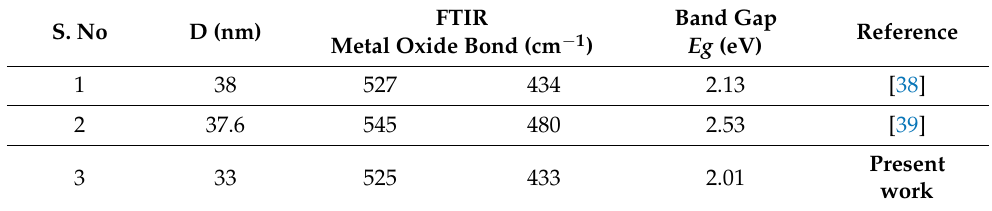
Table 2. UV-DRS bandgap comparisons with XRD and FTIR of α -Fe 2 O 3 nanoparticles. FTIR Band Gap S. No D (nm) Reference Eg (eV) Metal Oxide Bond (cm − 1 ) 1 38 527 434 2.13 [38] 37.6 545 2.53